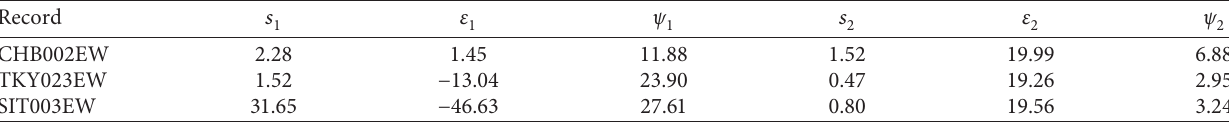
Figure 12: Comparison of the fitted models with actual records in terms of normalized power spectrum at specific columns. (a) CHB002EW and (b) TKY023EW. Table 4: Parameters controlling μ for each column.